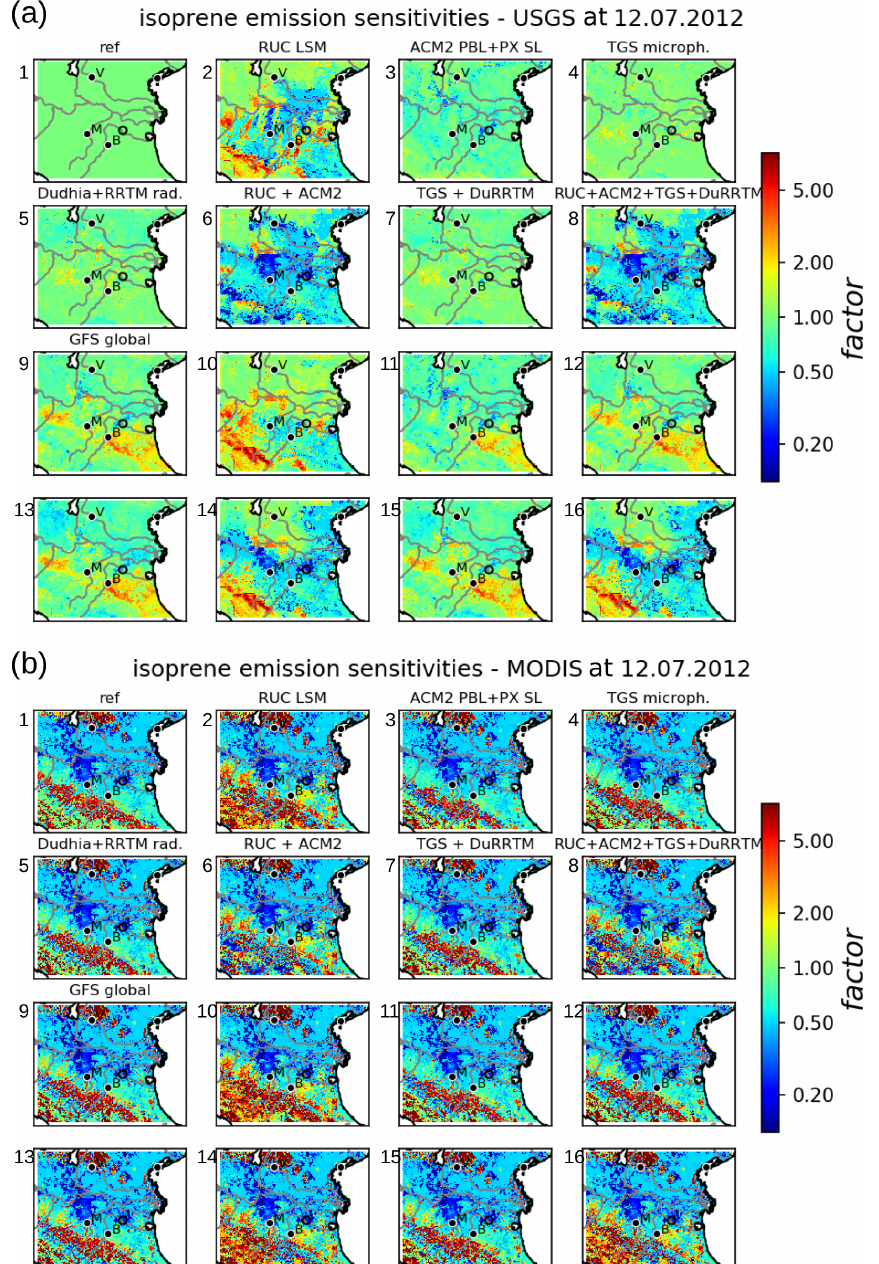
Figure 3. Set of combined sensitivities of isoprene emissions. Shown are isoprene emission factors for different combinations of model arguments as simulated by EURAD-IM. Emission factors are temporally averaged ratios of emissions divided by the reference emissions. The specific setup used for each of the 32 sensitivities is given in Table B1. The sensitivities are divided into those using USGS (a) and MODIS (b) land use information; numbers attached to the individual subplots refer to the numbers in Table B1. In addition, a short abbrevi- ation of the setup is given above each subplot. See also Vogel and Elbern (2021a) for a detailed description of the abbreviations and model implementations. Some major cities (Verona, Bologna, Modena) are indicated by their initial